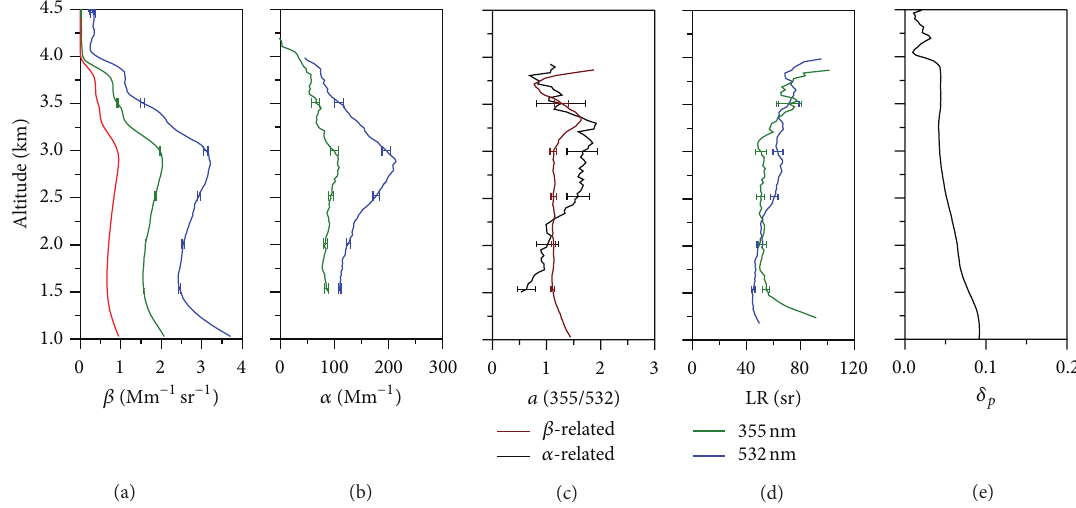
Figure 4: Profiles of (a) backscatter coefficients (355-blue, 532-green, and 1064 nm-red), (b) extinction coefficients (355-blue and 532 nm- green), (c) backscatter and extinction-related ˚Angstr¨om exponent (wavelength pair 355/532 nm), (d) lidar ratios (355 and 532 nm), and (e) particle linear depolarization ratio (532 nm) measured on 18 October 2011 at 19:00–20:45 UTC. 1.01.52.02.53.03.54.04.5